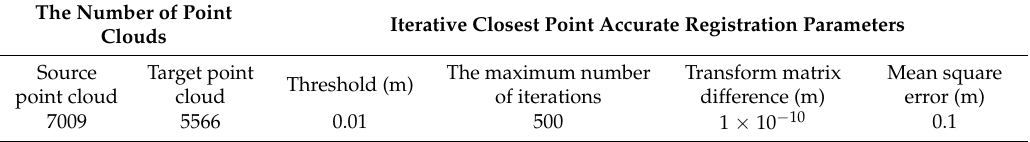
Table 1. The experimental parameters.